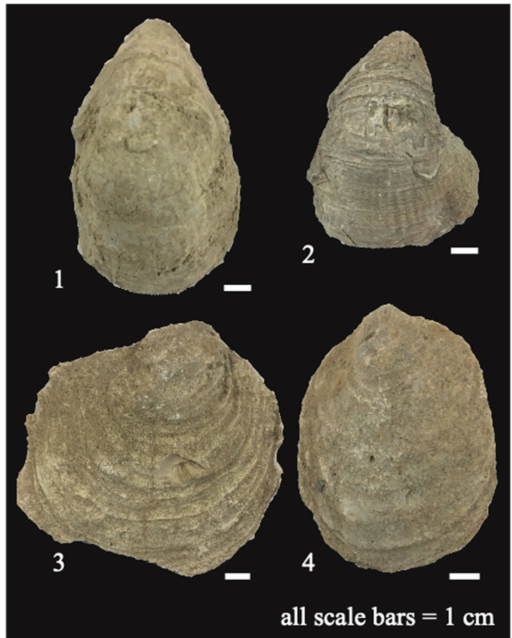
Figure 7. Photographs showing macrofossils obtained from the study sections. ( 1 ) Gryphaea (Po- jarkovy) angulata , FS61, Varzyk section. ( 2 ) Ostrea (Turkostrea) bellovacina , FS42, Karabulak section. ( 3 ) Pycnodonte sp. FS12, Karabulak section. ( 4 ) Liostrea sp. FS31, Karabulak